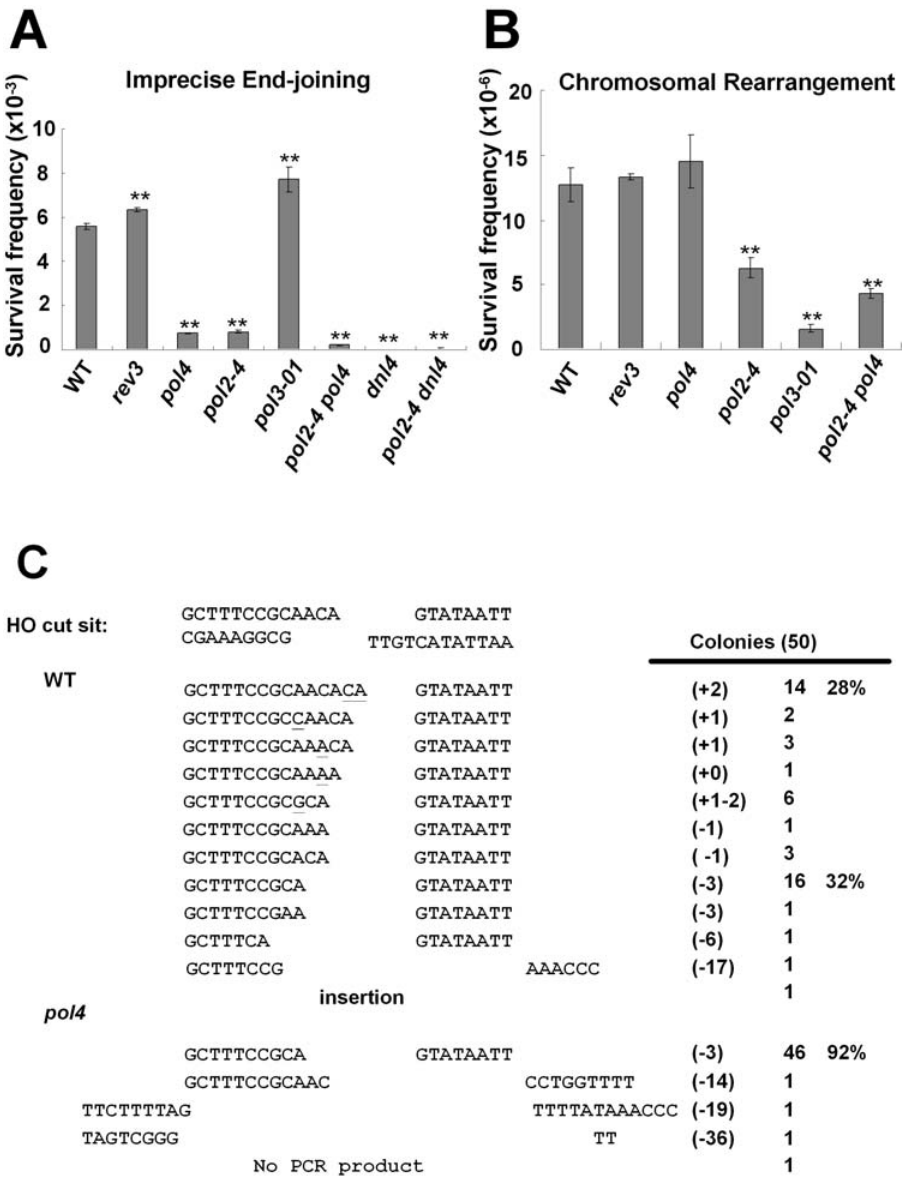
Figure 2. Measurements of NHEJ ability of non-essential DNA polymerases. The efficiency of NHEJ of wild-type and polymerase defective mutants, rev3 , pol4 and 3 9 to 5 9 exonuclease defective mutants, pol2-4 , pol3-01 , pol2-4 pol4 , dnl4 , and pol2-4 dnl4 were measured. (A) Frequencies of imprecise end joining. The survival frequency was evaluated by the ratio of YPGal/YPD. (B) Frequency of chromosomal rearrangement was evaluated by the ratio of FOA R /YPD. Each experiment was collected from at least four independent clones. *: P , 0.05; **: P , 0.01. (C) The sequence analysis of the imprecise end joining events from the WT and pol4 mutants. The structures of various imprecise end joining repairs were identified at the DSB site. Sequences of the HO cut site are shown, with the resulting 3 9 overhanging terminal AACA shown on the cut site. Samples of independent joints were PCR amplified and sequenced. A total of 50 independent survivors on YPGal plates from WT and pol4 mutant were examined. Bases underlined indicate insertion or mutation. The numbers of inserted ( + ) and deleted ( 2 ) bases were denoted in brackets. N indicates the events of each repair pattern. URA3 point-mutations) was estimated as the ratio of colonies We first compared cell survival after a DSB in strains with or growing on FOA-containing media compared to colonies growing without disruption of nonessential polymerases. The wild-type on YPD, because insertion or deletion of large fragments results in strain, AGY673, had a frequency of imprecise end joining and disruption of splicing and consequent FOA resistance. Addition- chromosomal rearrangement events of 5.58 6 10 2 3 and 1.27 6 10 2 5 per plated cell, respectively (Figure 2A, 2B, and Table S1). ally, chromosomal translocations and inversions can also disrupt Elimination of Rev3 ( rev3 ) did not alter the frequency of imprecise the integrity of the URA3 gene and cause FOA resistance [31]. It end joining (6.33 6 10 2 3 ) or chromosomal rearrangement events should be noted that the level of analysis carried out in this work (1.33 6 10 2 5 ), suggesting that Rev3 is not required for the NHEJ (Figure S1) does not definitively distinguish translocations and pathway. In contrast, elimination of Pol4 resulted in an 8.6-fold inversions from insertions.